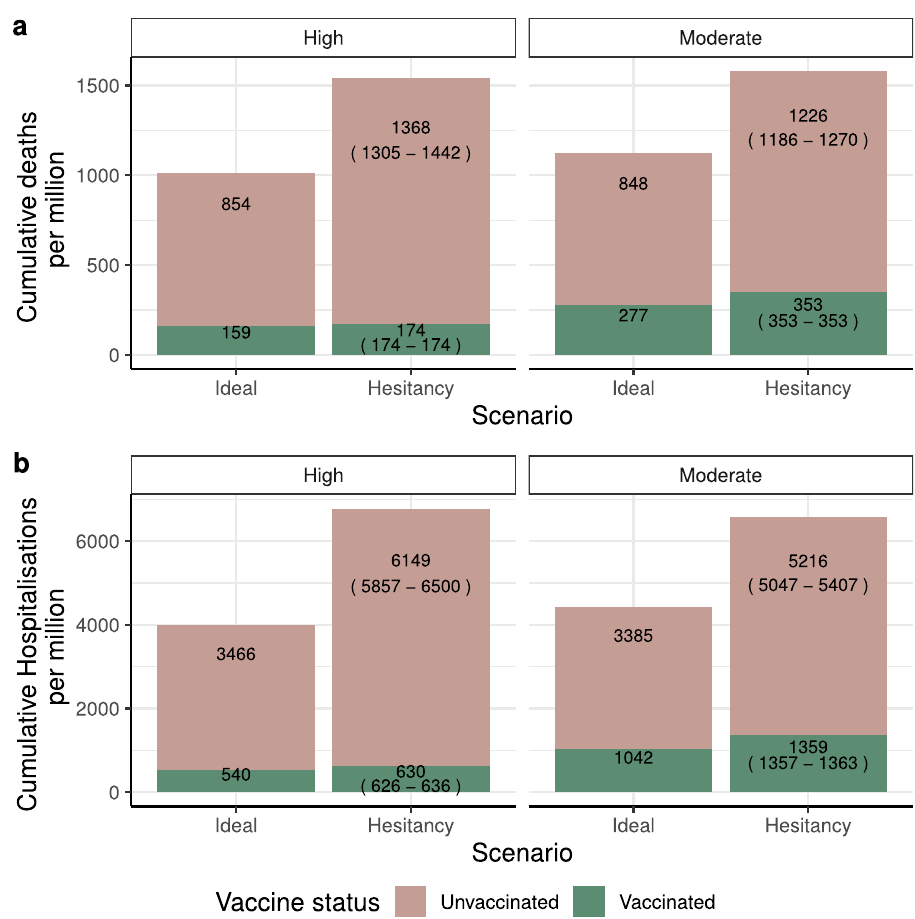
Fig. 2 Public health impact of vaccine hesitancy. High vaccine ef fi cacy is shown on the left and moderate vaccine ef fi cacy on the right. The annotated numbers are the cumulative deaths ( a ) and hospitalisations ( b ) per million individuals for the vaccinated and unvaccinated populations at the end of the projection horizon (1 January 2021 – 31 December 2022). Vaccination coverage of individuals aged 15 years and older is highest in the ideal scenario at 95%. For the hesitancy scenario annotated number is for median vaccine coverage per age groups, number in parenthesis are results for 10% and 90% quantiles coverage per age